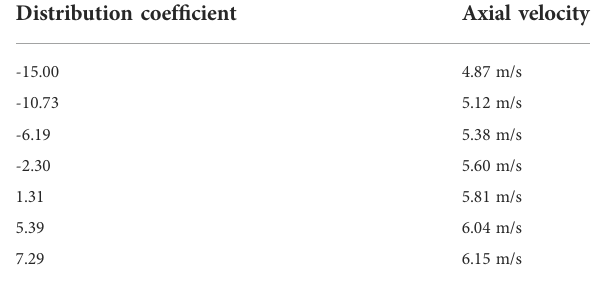
FIGURE 12 Transverse vibration response under different axial fl ow